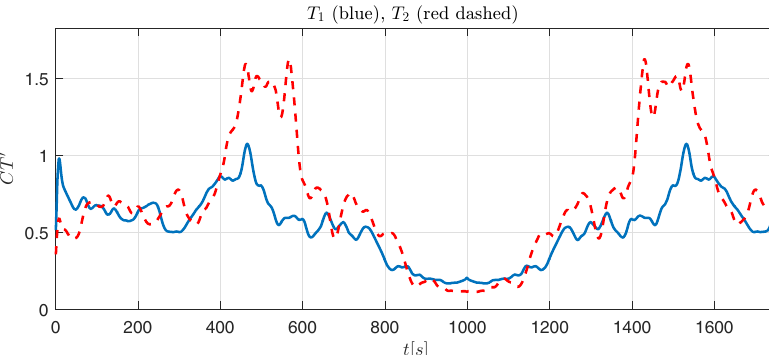
Figure 8. Excitation signals for the two-turbine simulation case. The yaw angles are set to zero.